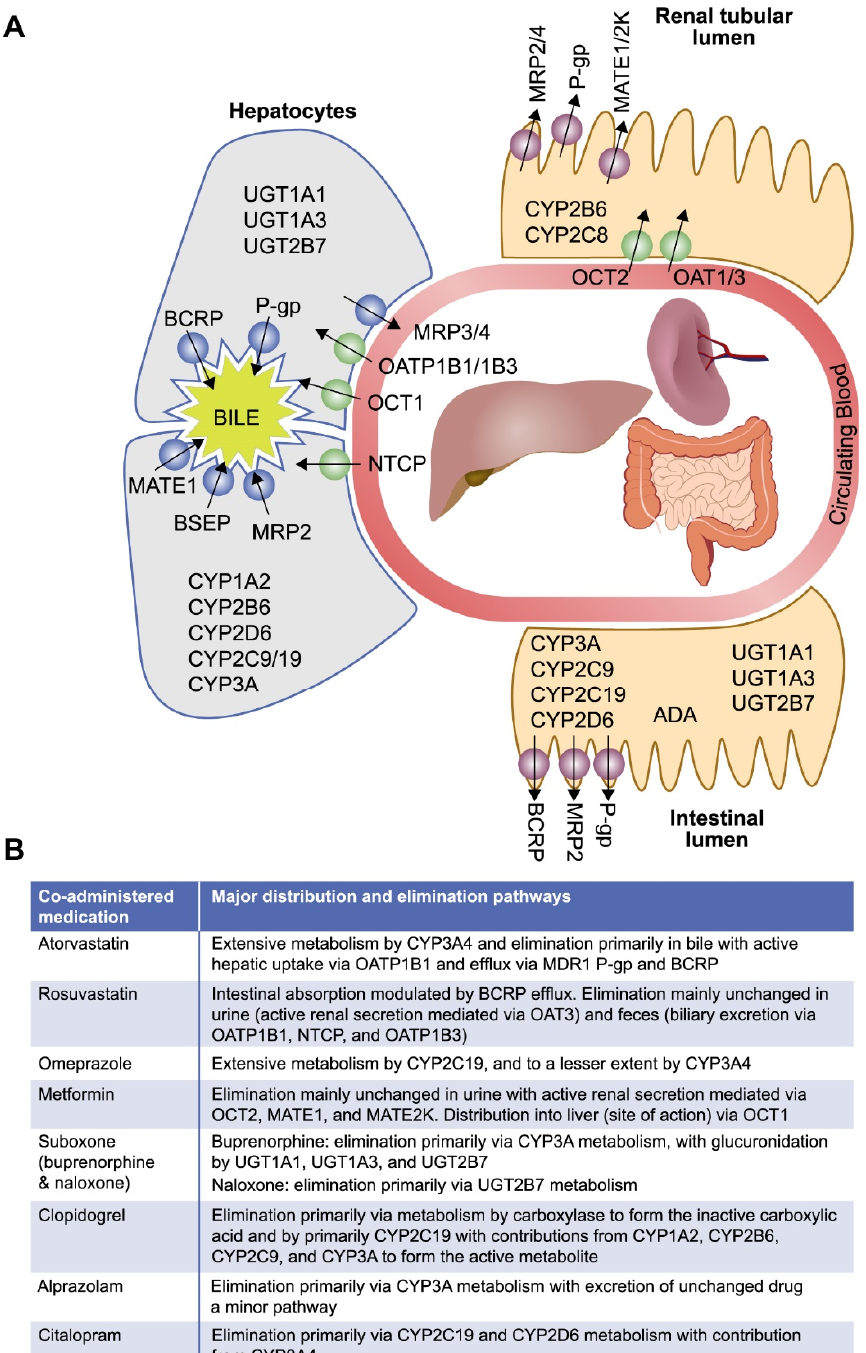
Figure 2. Key elimination pathways of commonly co-prescribed medications * [34–53]. ( A ) Location of drug-metabolizing enzymes and transporters of interest. ( B ) Elimination and distribution path- ways for co-administered medications with islatravir *. ADA, adenosine deaminase; BCRP, breast cancer resistance protein; BSEP, bile salt export pump; CYP, cytochrome P450; MATE, multidrug and toxin extrusion protein; MDR1 P-gp, multidrug resistance protein 1 P-glycoprotein; MRP, multidrug resistance-associated protein; OAT, organic anion transporter; OATP, organic anion transporting polypeptide; OCT, organic cation transporter; NTCP, sodium taurocholate co-transporting polypeptide; UGT, uridine diphosphate glucuronosyltransferase. * Commonly prescribed co-medications taken from European Medicines Agency scientific advice on metabolic and elimination path- ways for key medications expected to be taken concomitantly with islatravir.